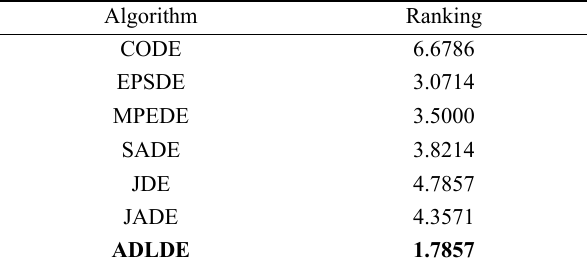
Table 6 Friedman test ranking when D = 10.